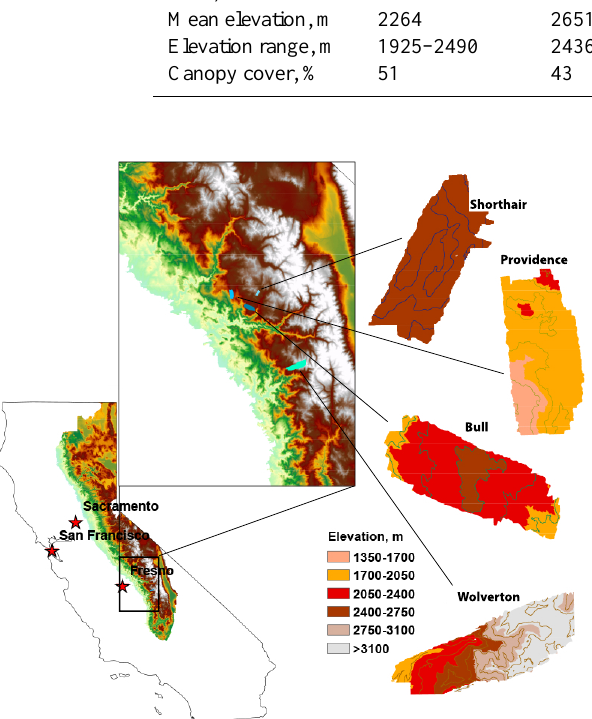
Figure 1. Study area and lidar footprints. Left: California with Sierra Nevada. Center: zoomed view to show the locations of li- dar footprints. Right: elevation and 200m contour map (100m for Bull) of lidar footprints.